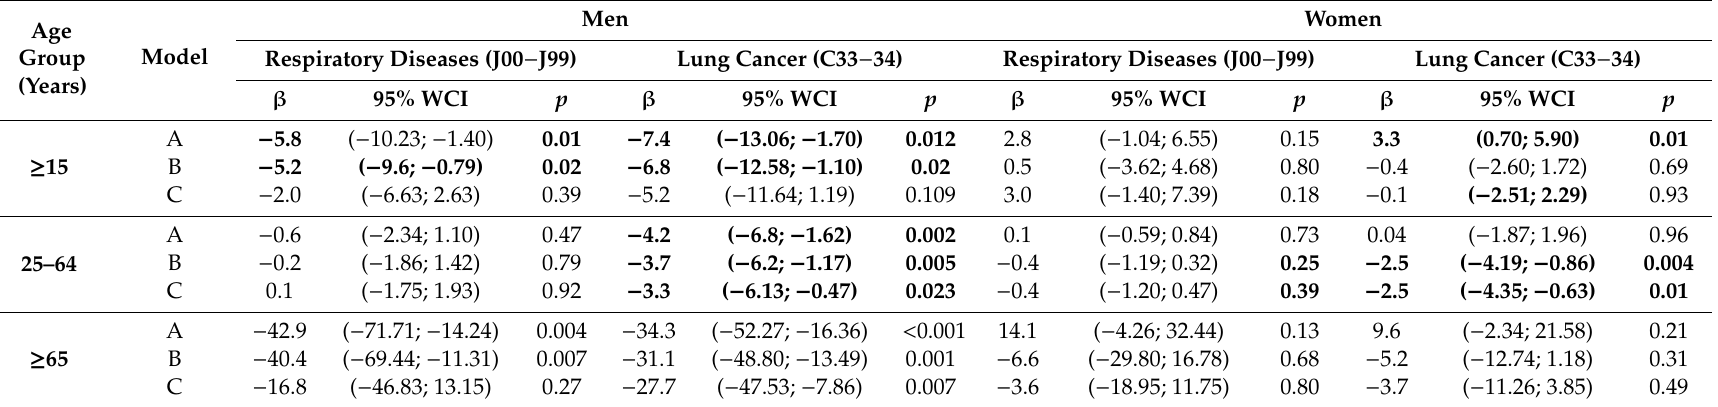
Table 2. Relationship between socioeconomic status (SES) in 2010 and mean SMR for respiratory diseases and lung cancer in 66 sub-regions of Poland. Age